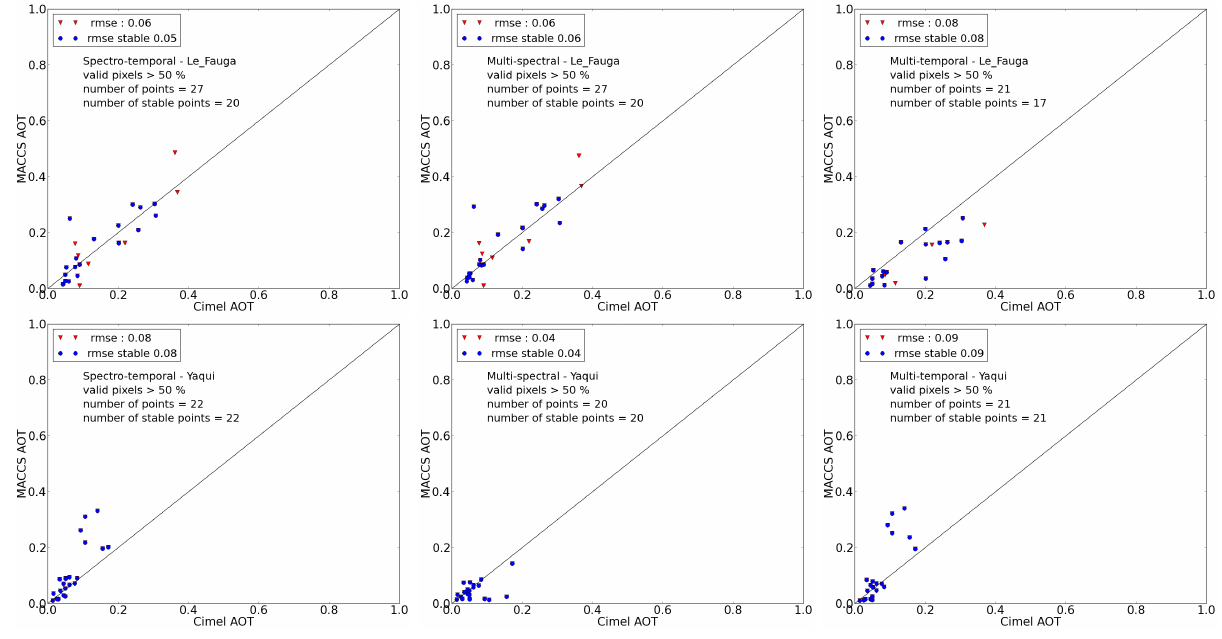
Figure 8. Comparison of AOT estimates at 550 nm obtained from hybrid ( left ), multi-spectral (MS) ( middle ) and MT ( right ) methods for two Formosat sites: Le Fauga (top); Yaqui (bottom). Blue circles correspond to stable conditions and red triangles to unstable conditions.